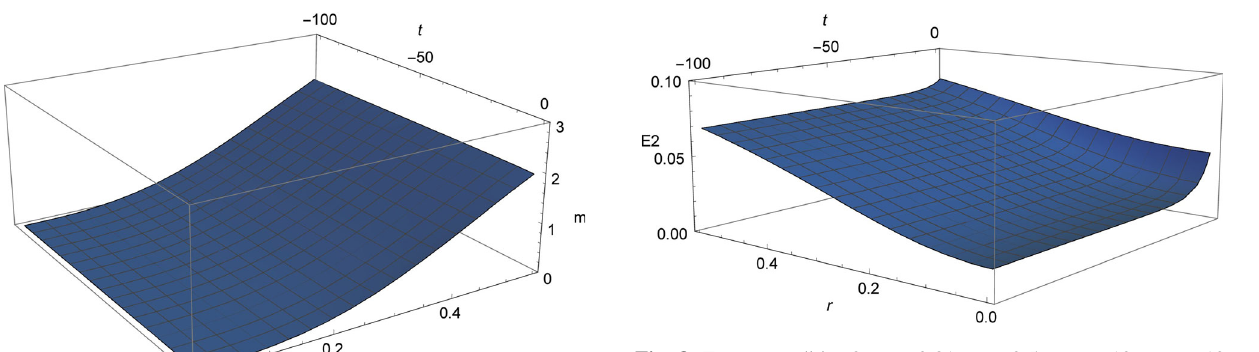
Fig. 8 Energycondition2, c 1 = 0 . 81, c 2 = 0 . 5, c 3 = − 10, c 4 = − 10, ζ = − 0 . 2, R = 6 . 62, r = 0 . 55 and (cid:7) = 0 . 1 0